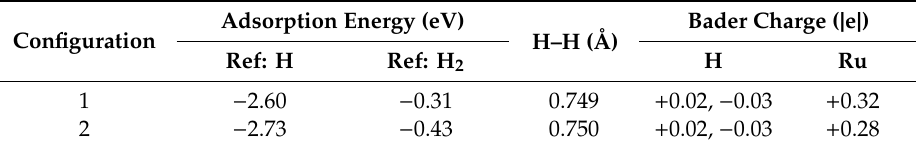
Table 6. Calculated adsorption energies with respect to gas phase molecular hydrogen, H–H bond distances and Bader charges on the Ru and H